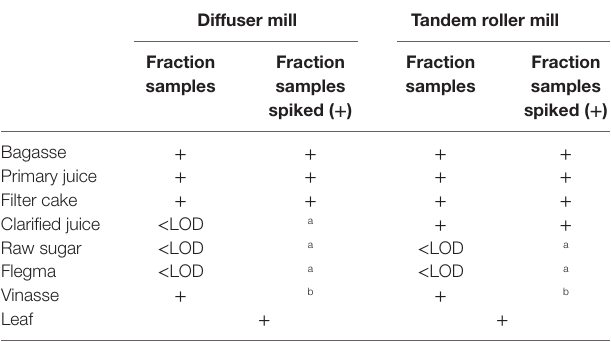
TaBle 13 | RuBisCO DNA detection in fractions collected during industrial processing of sugar and ethanol production from two types of sugarcane